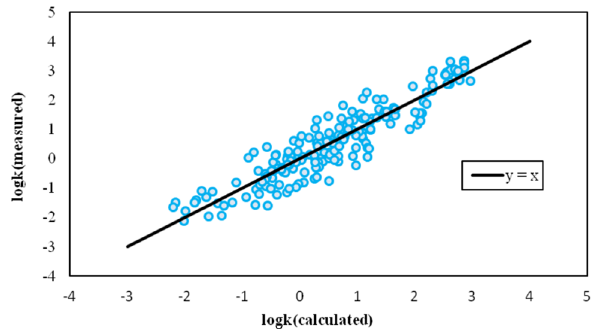
Fig. 7 Cross-plot of measured and calculated permeabilities using Eq.